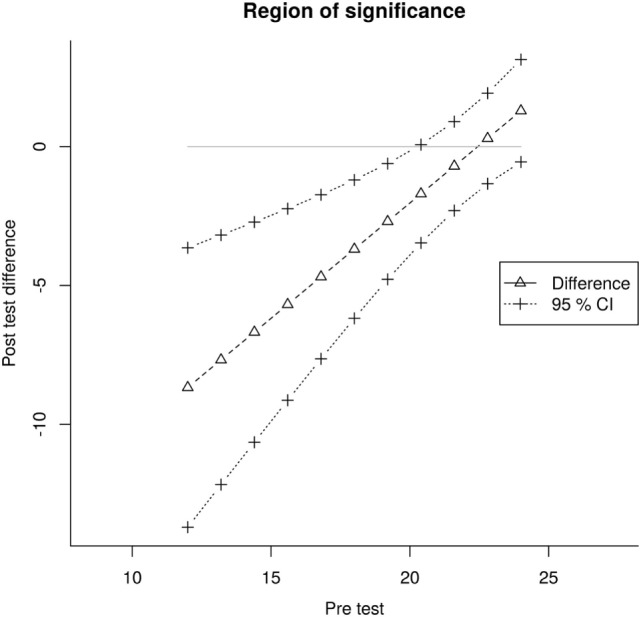
Fugl–Meyer joint pain subscale results. Taking into account the unequal regression slopes of CG and MG, the Johnson–Neyman technique estimates the two groups’ post-test difference (triangles, dashed straight line) from the joint pretest values and determines upper and lower confidence intervals (CI; crosses, dotted lines). The triangles and crosses do not represent individual data points but estimated values. The CIs and the solid straight line at y = 0, confine the area where the two groups differed significantly in their post-test Fugl–Meyer Joint pain score. Compared to CG patients, MG patients with a pretest score below 20 seemed to benefit from the additional sonification therapy.